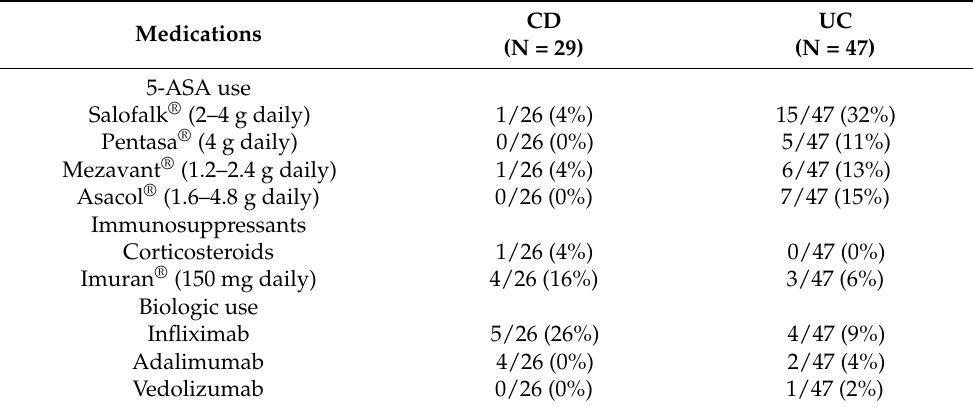
Table 3. IBD medications and doses used in